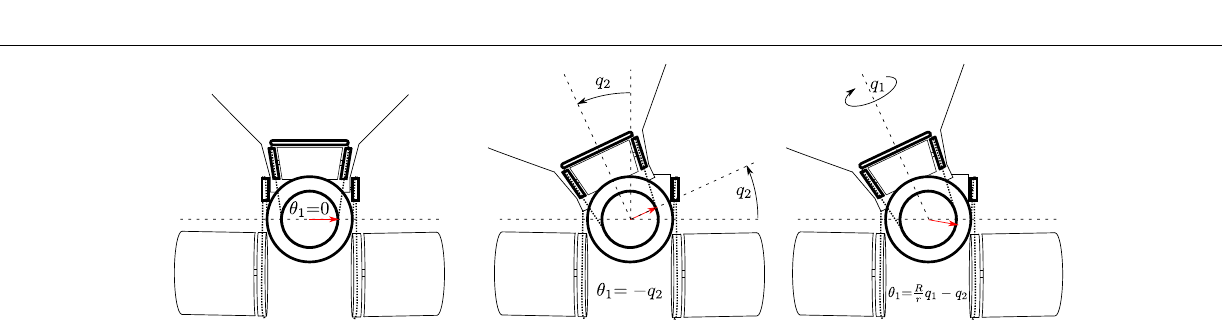
equations (3) and (4) with substitutions τ ↔ τ θ and ˙ q ↔ ˙ θ